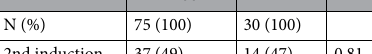
LAM2001D FAMYLY